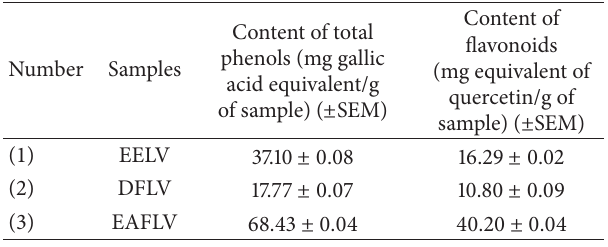
Table 2: FRAP test of the ethanolic extract and fractions of L. venustum .